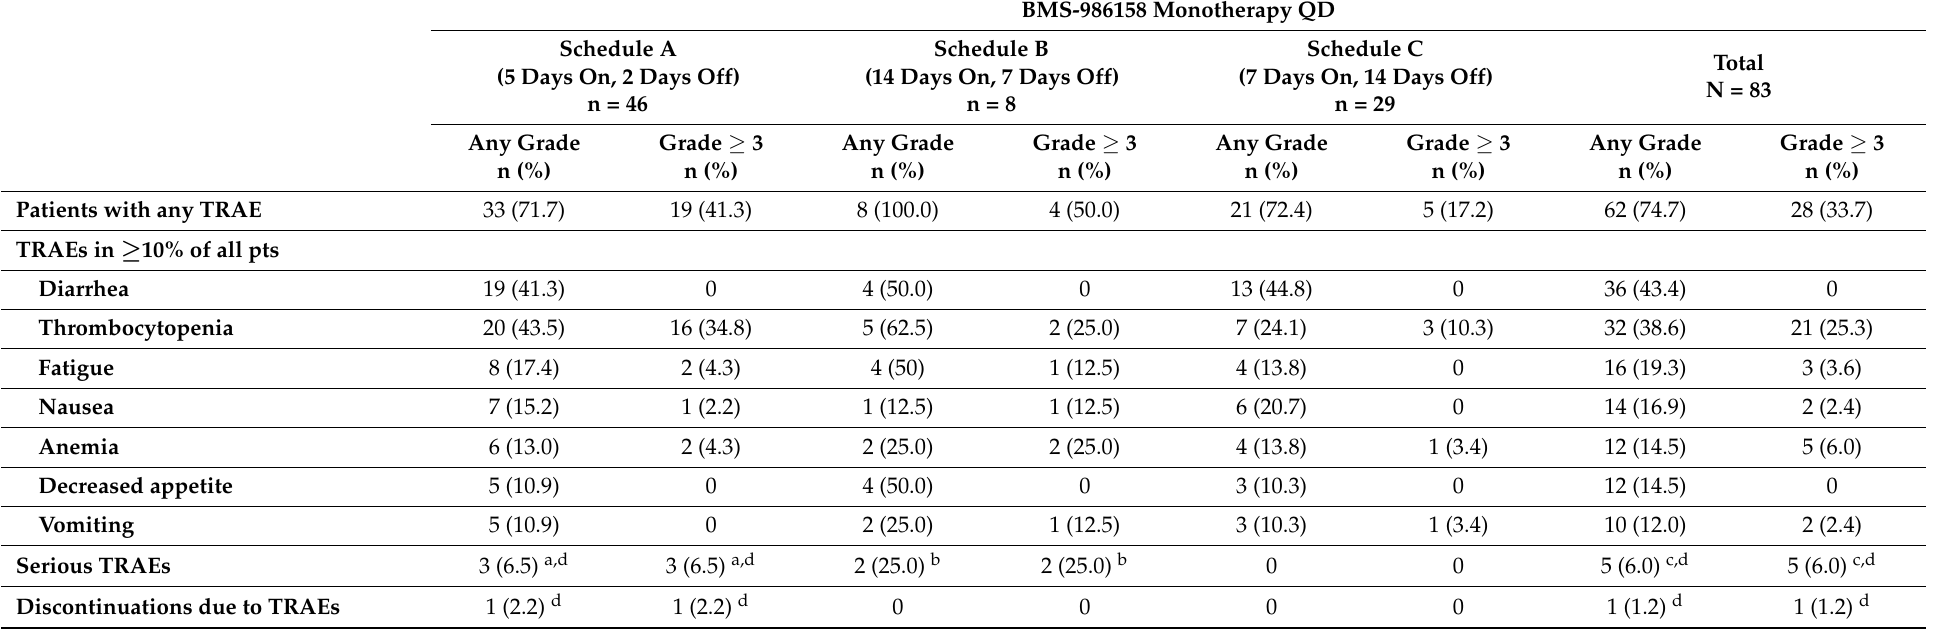
Table 2. Safety summary of TRAEs by dosing